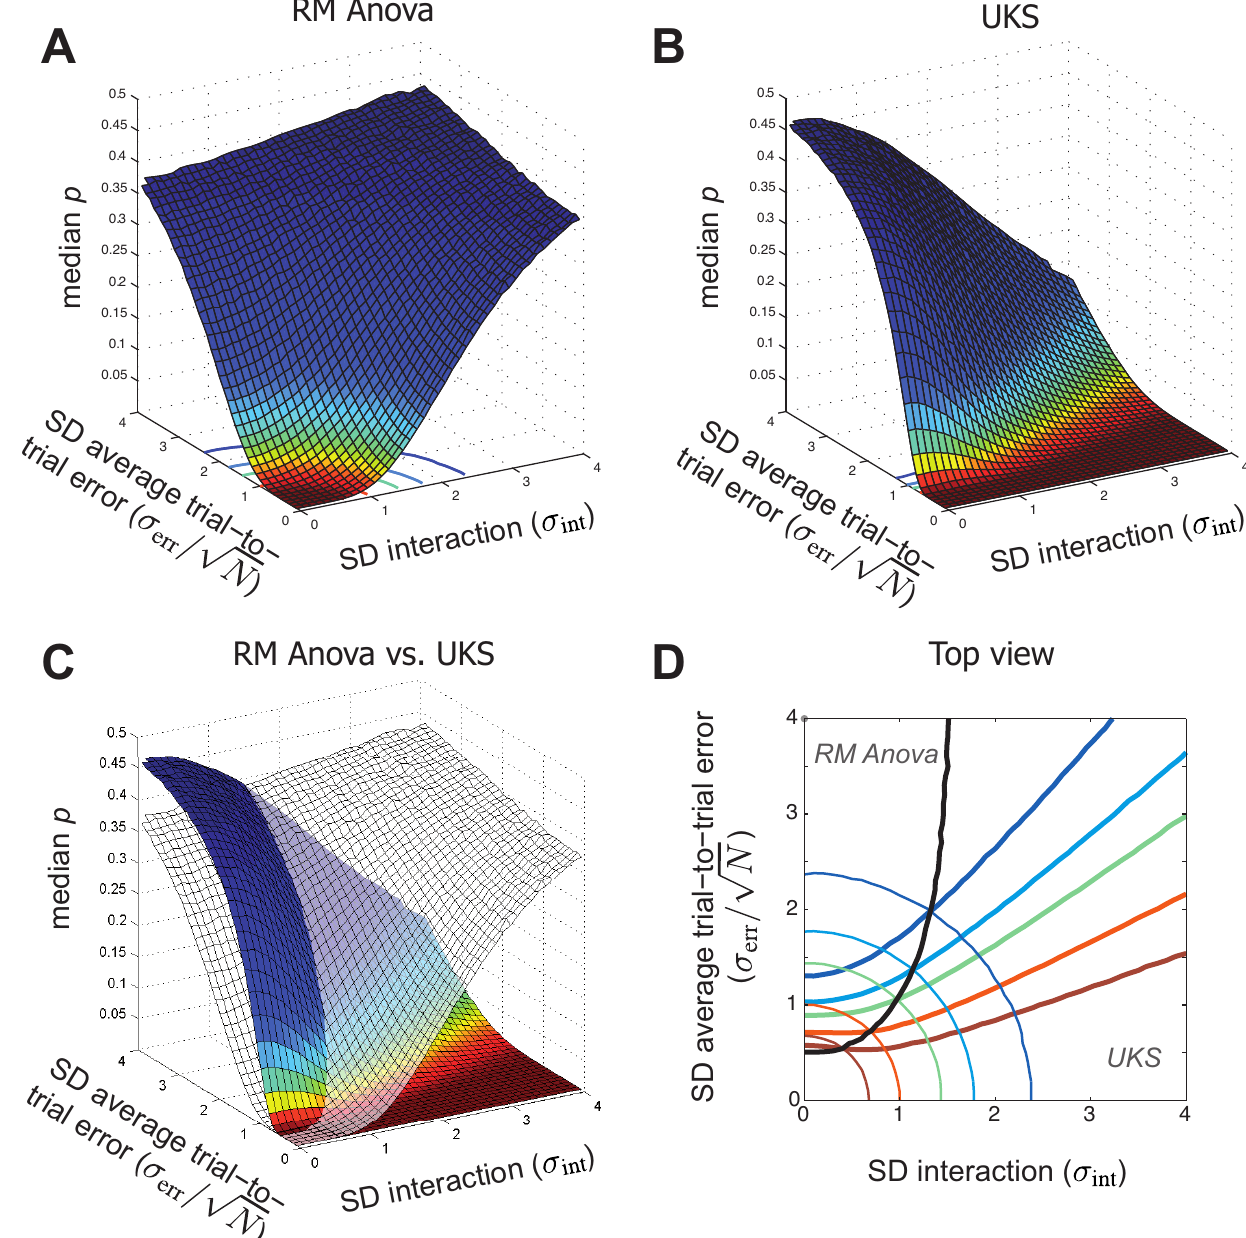
Figure 1. Comparison of type II error rates in UKS test and RM Anovas . Results of a simulation study based on over one billion datasets. Each dataset represents the data of 10 individuals performing 10 trials in each of the 2 levels of a factor. Each data point was obtained by adding to the fixed central value of the level ( 2 1/ ! 2 or + 1/ ! 2) two random Gaussian values representing individual idiosyncrasies and trial-to-trial errors (see Methods). Panel A: Median probability (Z-axis) yielded by RM Anovas as a function of the standard deviations of subject-factor interaction (X-axis, rightwards) and average of 10 trial-to-trial errors (Y-axis, leftwards). Panel B: Median probability yielded by the UKS test for the same random data. Panel C: superimposition of the surfaces displayed in panel A and B. Note that in conditions when UKS test is less powerful than ANOVA (larger median p), the difference in power is never dramatic; the converse is not true. Panel D: 2D-isolines of the surfaces in panel C for median probabilities. 001 (red), .01 (orange), .05 (green), .10 (light blue) and .20 (dark blue). Black line: projection of the intersection of the two surfaces; RM Anova is more powerful (smaller median probability) than the UKS test for points leftwards of the black line. Note that scaling the X-axis to the SD of within-level averages of trial-to-trial errors gives a symmetrical aspect to RM Anova surface and projection. opposite effect was occasionally added. Thus, in our Monte-Carlo that displayed the average effect d , no effect, or occasionally an simulations the trial-to-trial variability was constant while two average opposite effect – d (see Methods for details). parameters varied: the effect size, defined as the difference d Panels A and B in Figure 2 show the proportion of significant between the two factor levels, and the proportions of population RM Anovas (continuous line) and UKS tests at the.05 (dashed)